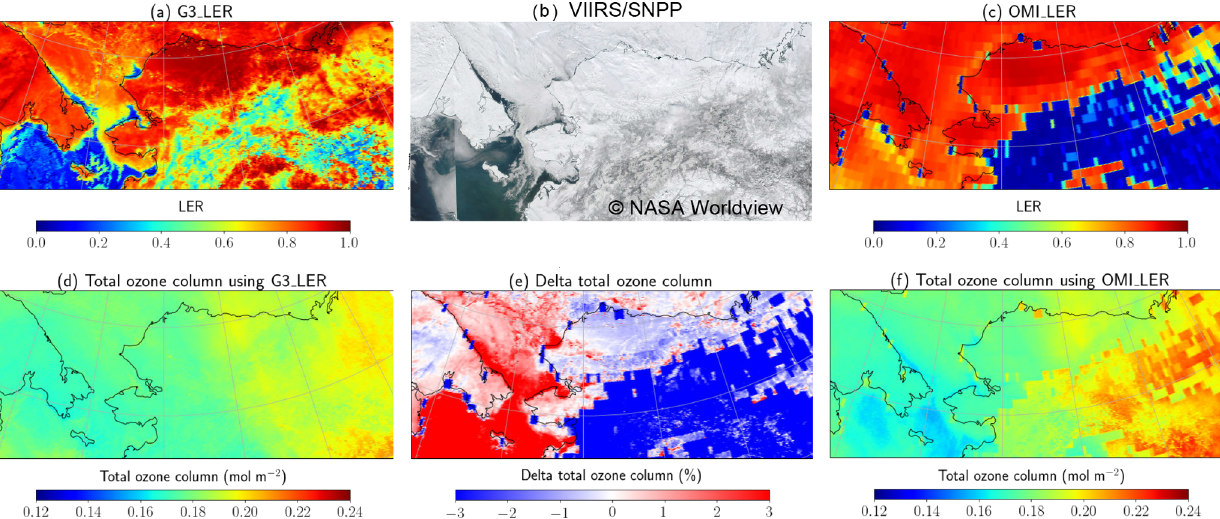
Figure 12. TROPOMI/S5P (a–c) surface and (d–f) ozone measurements from 1 April 2018 around the Bering Strait. The (a) TROPOMI/S5P G3_LER daily map agrees very well with the surface types observed in the (b) VIIRS/SNPP image coastal waters of Russia and Alaska. These coastal waters and the open waters of the Bering Sea are not properly represented in the (c) OMI LER climatology, which shows snow/ice over these regions. Likewise, the OMI LER climatology erroneously shows no snow/ice in Alaska. The total ozone field using the (d) TROPOMI G3_LER daily map is significantly smoother than the field derived from the (f) OMI LER climatology. The coarse spatial resolution of the OMI LER climatology is clearly manifested in the total ozone field and incorrect snow/ice values in the OMI LER climatology induce large errors in the retrieved total ozone (e) , with differences between − 10% and +